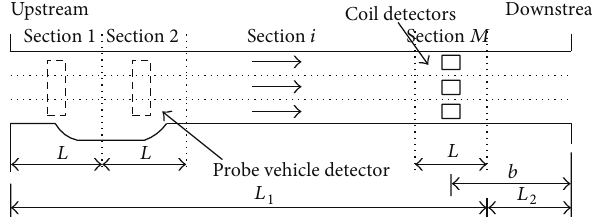
Figure 7: Speed estimation model of urban